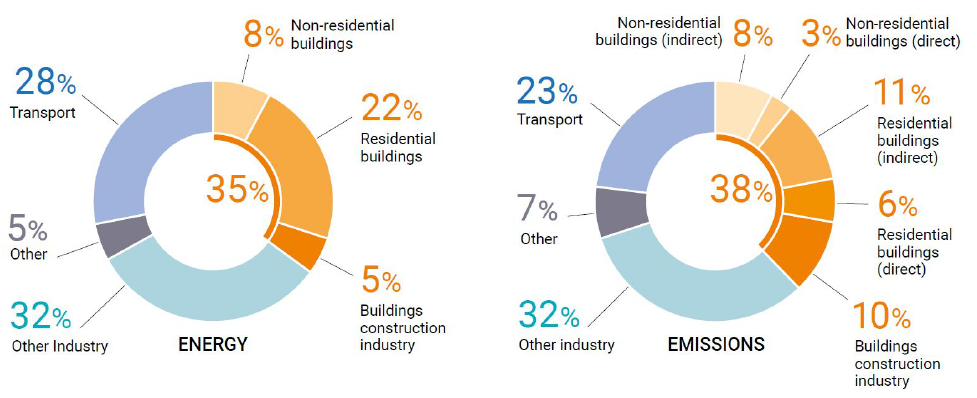
Figure 1. Global share of final energy and emissions by sector, 2019 [1–3].